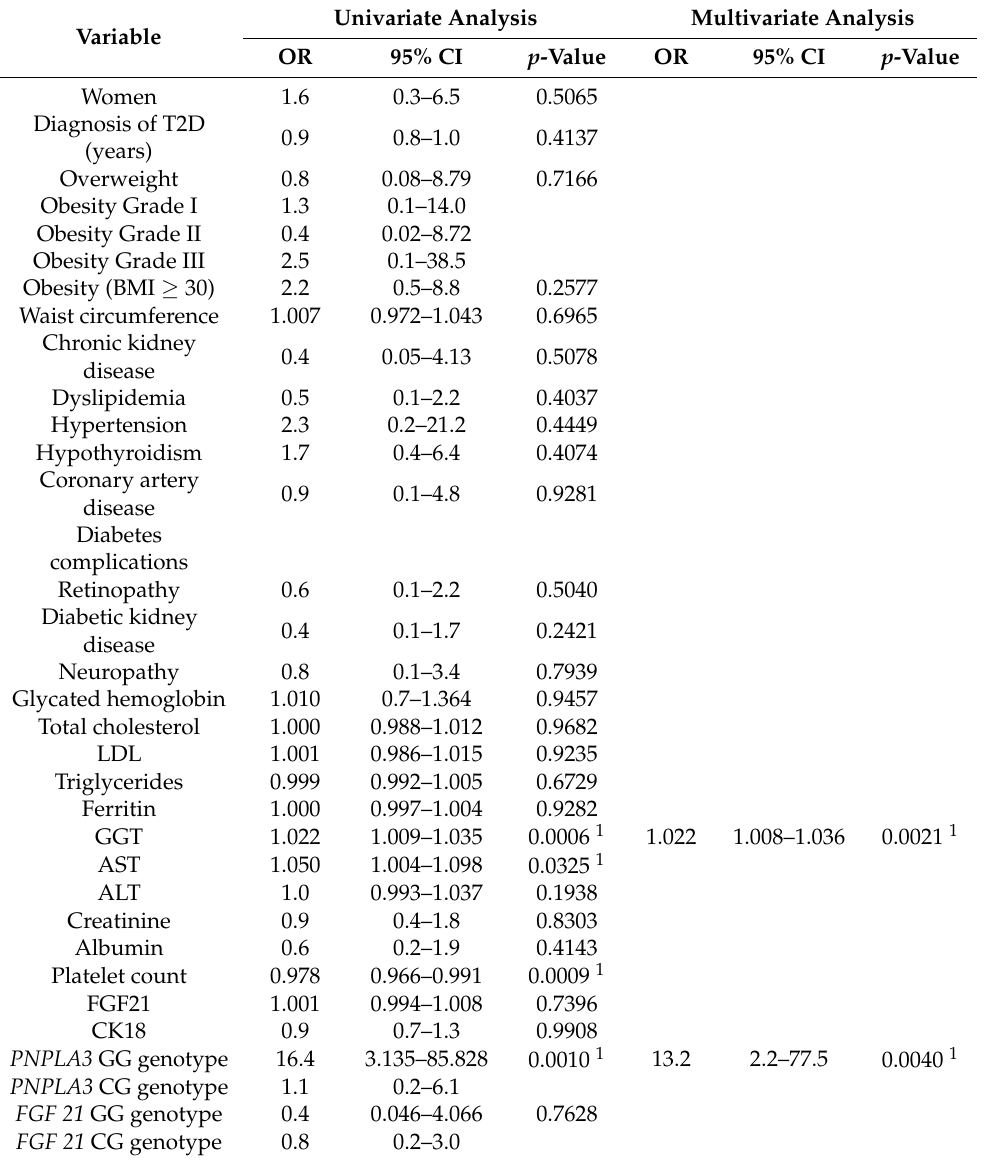
Table 4. Factors associated with cirrhosis in NAFLD patients with T2D ( n =